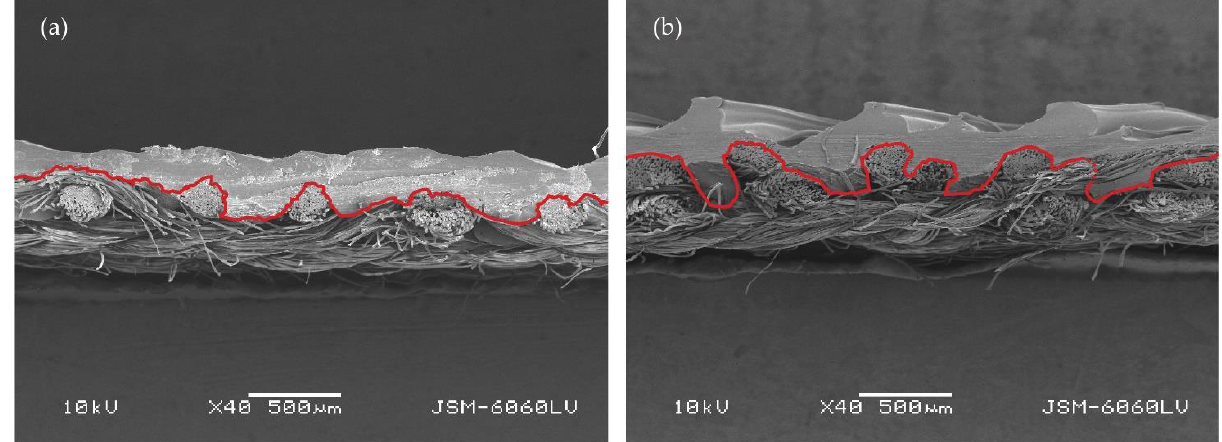
Figure 8. Cross-section (cut in the warp direction) of 3D printed fabrics at z = 0.25 mm (mag. 40×): ( a ) simple fabric T13Z 15; ( b ) double fabric DT13Z 30.